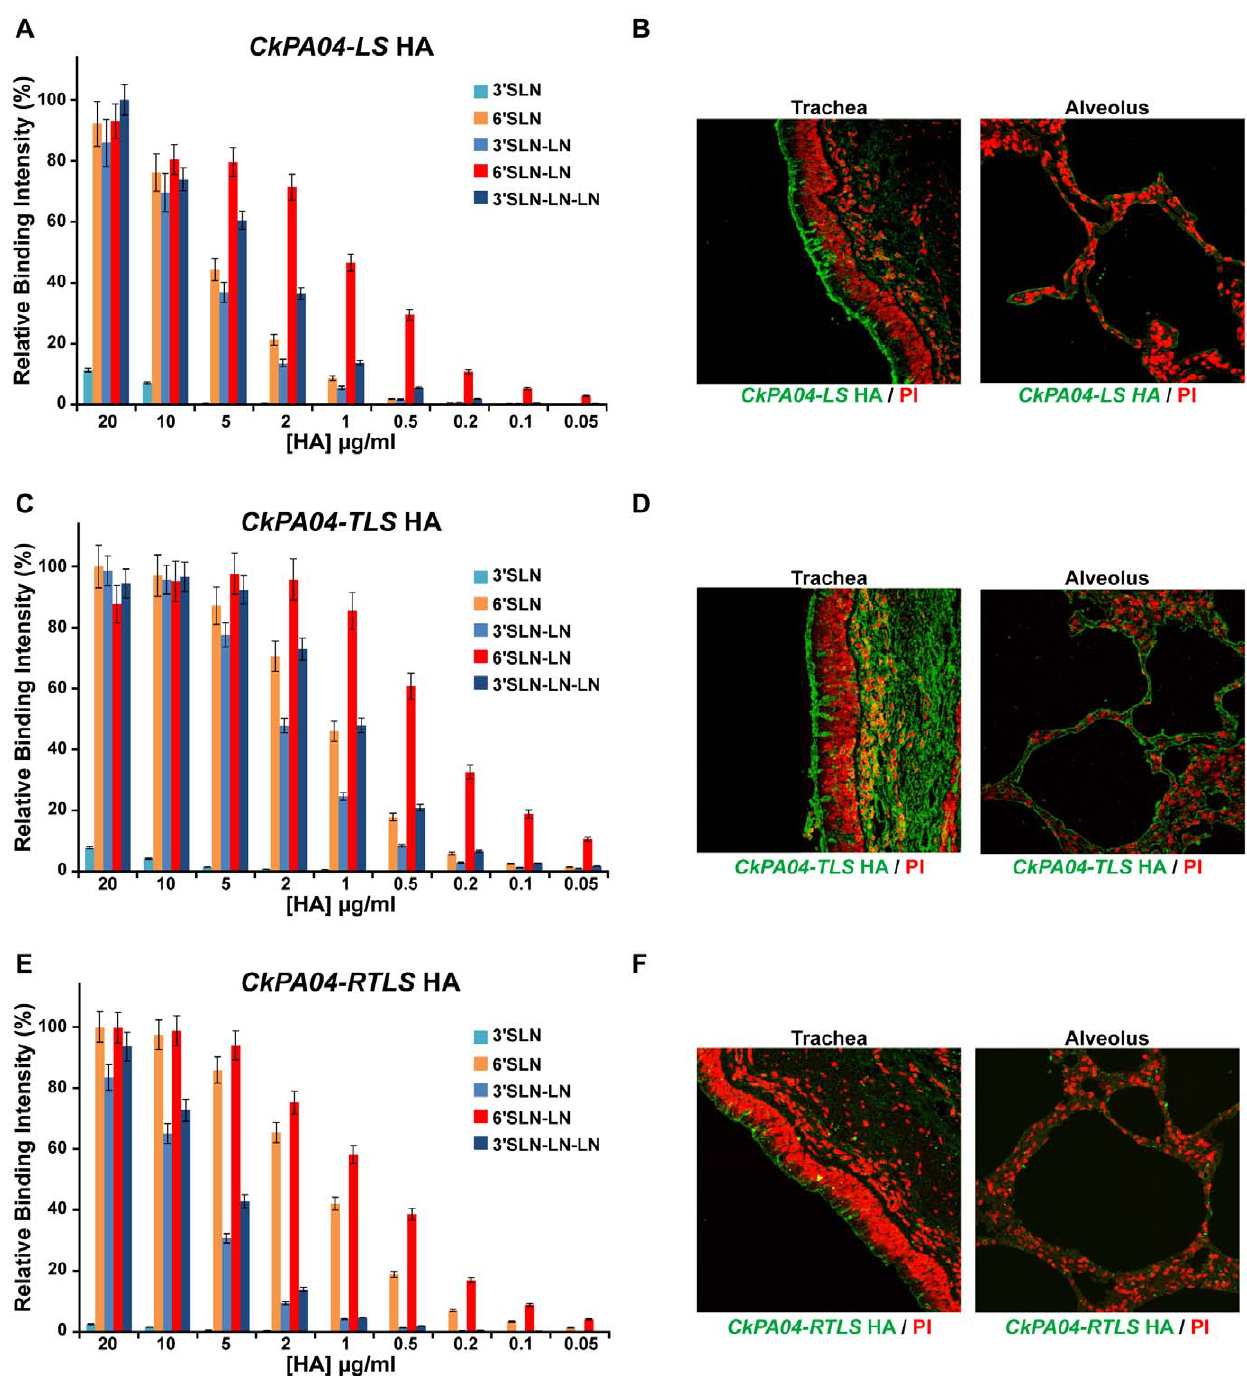
Figure 5. Glycan receptor-binding specificity of mutant forms of CkPA04 HA. Shown in the figure is the dose-dependent glycan receptor binding ( A,C,E ) and human tissue binding ( B,D,F ) of CkPA04-LS , CkPA04-TLS and CkPA04-RTLS mutants respectively. All the mutants show substantial improvement in the human receptor binding and reduction in avian receptor binding in comparison to the WT CkPA04 HA as observed in both the glycan array tissue-binding experiments.